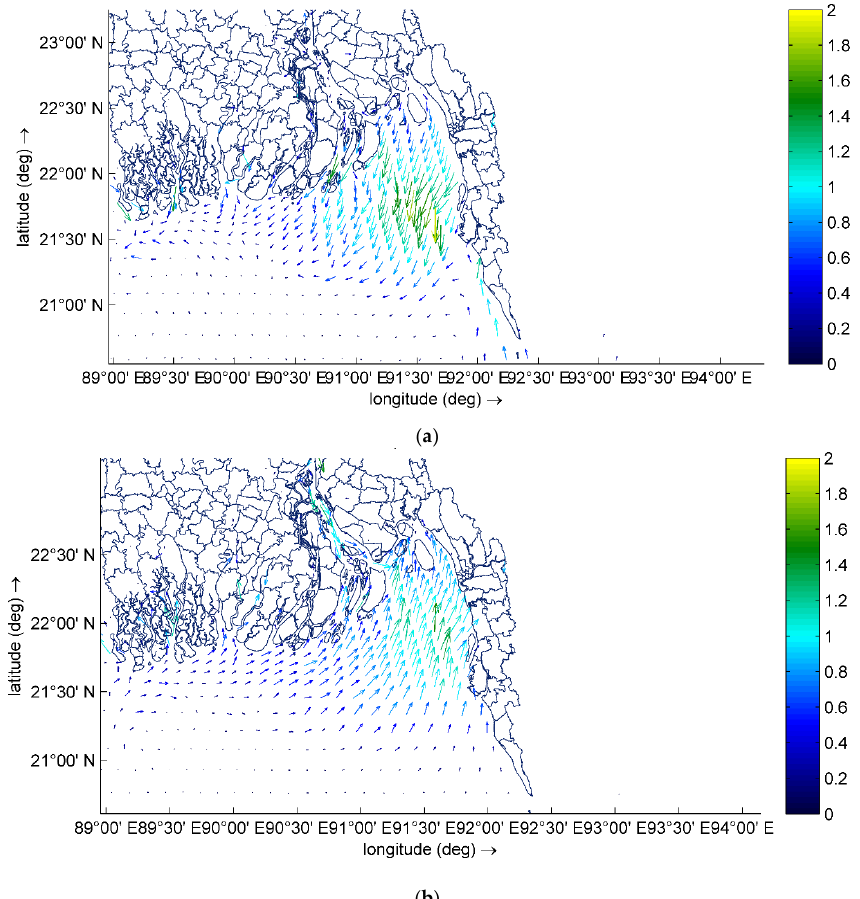
Figure 12. Vectors showing depth average velocity magnitude and direction during ( a ) TC Mora, and ( b ) the synthetic cyclone at the time of landfall.